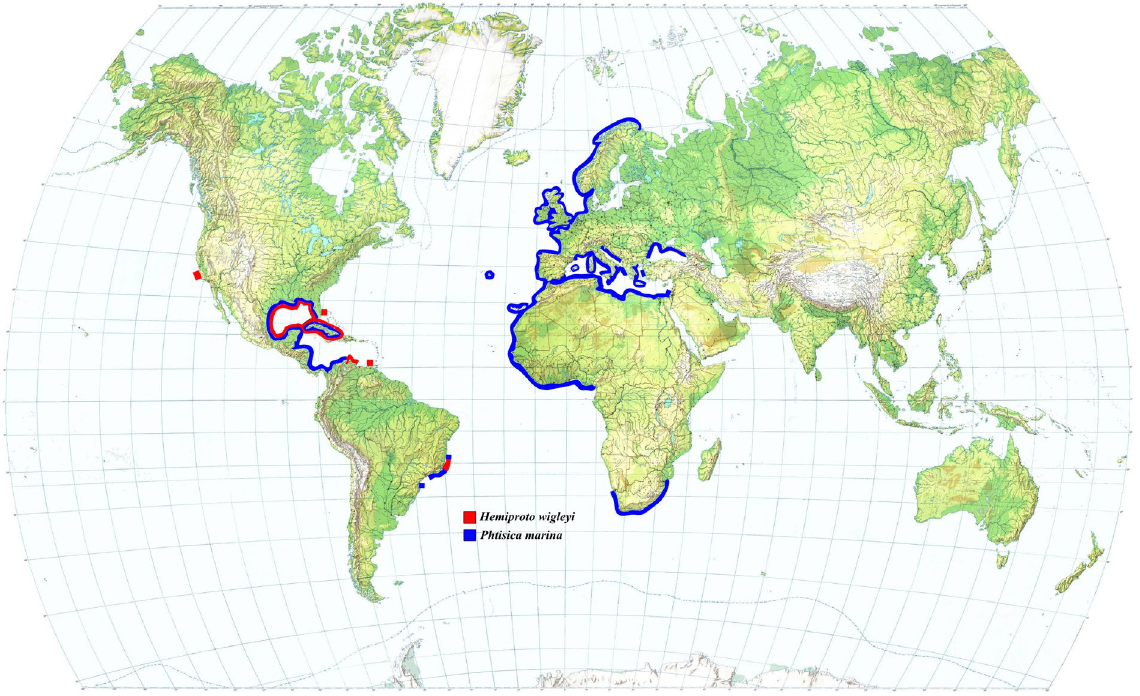
Fig. 6. World distribution of Phtisica marina Slabber, 1769 and Hemiproto wigleyi McCain,